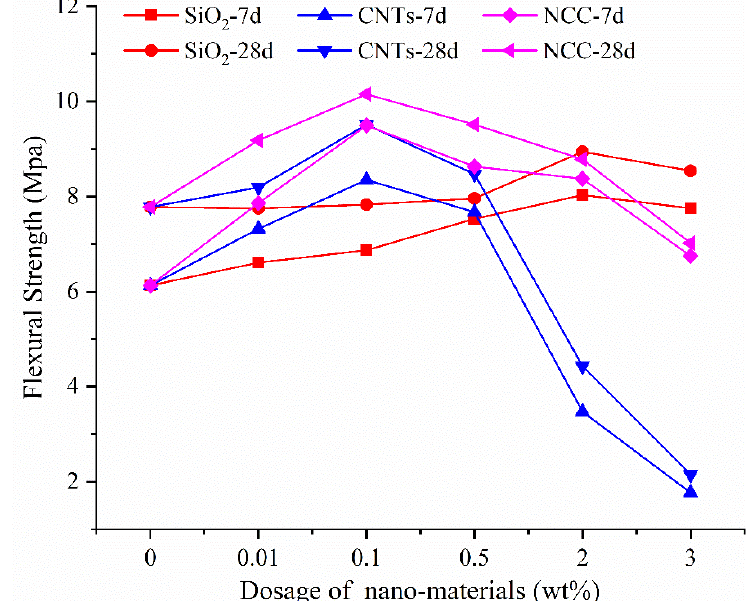
Figure 2. Effect of nanomaterial content on flexural strength. Figure 2. E ff ect of nanomaterial content on flexural strength.